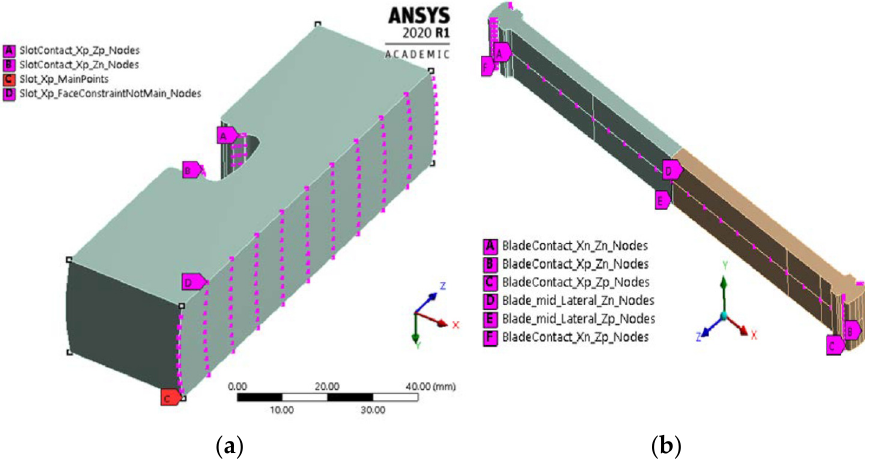
Figure 14. Master nodes for reduced model: ( a ) support and ( b ) beam.